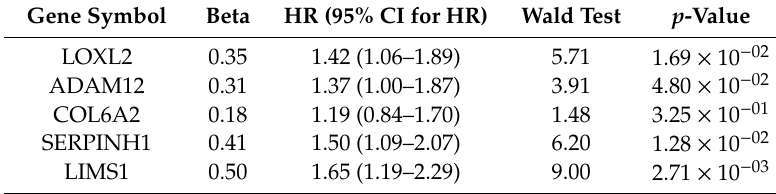
HR: hazard ratio; CI: confidence interval. Table 4. Univariate Cox regression analysis of miR-29c target genes based on the Netherlands cohort. Gene Symbol Beta HR (95% CI for HR)